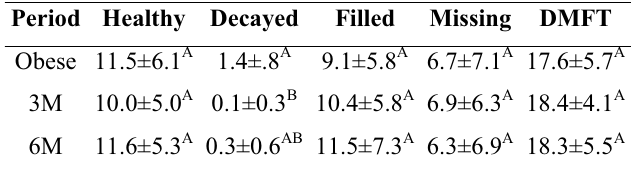
TABLE 1 - Mean and standard deviation of the DMFT index